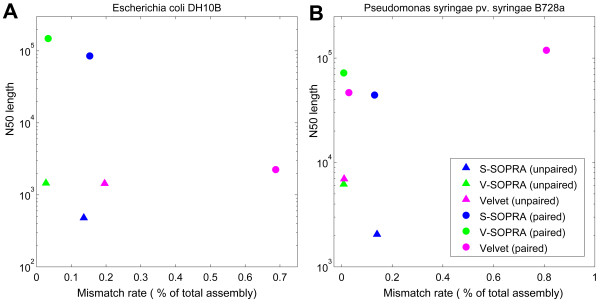
N50 vs. combined mismatch and no-match error rate for de novo assembly of real data. See main text and the caption for Table 1 for explanation of the error rates.